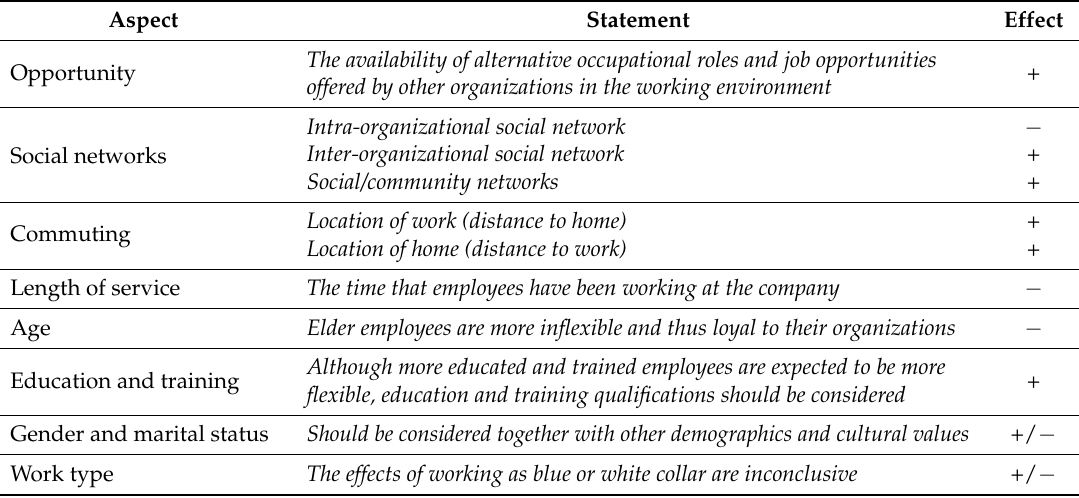
Table 2. Environmental and individual causes of turnover intention (TI) and their presumed effects. Aspect Statement